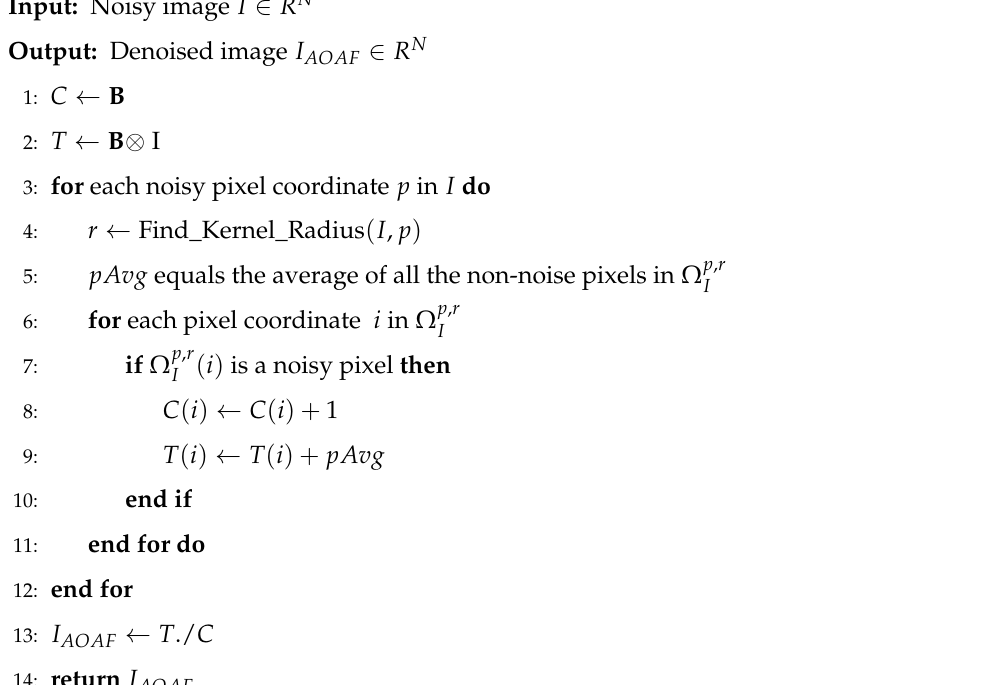
Algorithm 1 Adaptive and Overlapped Average Filter